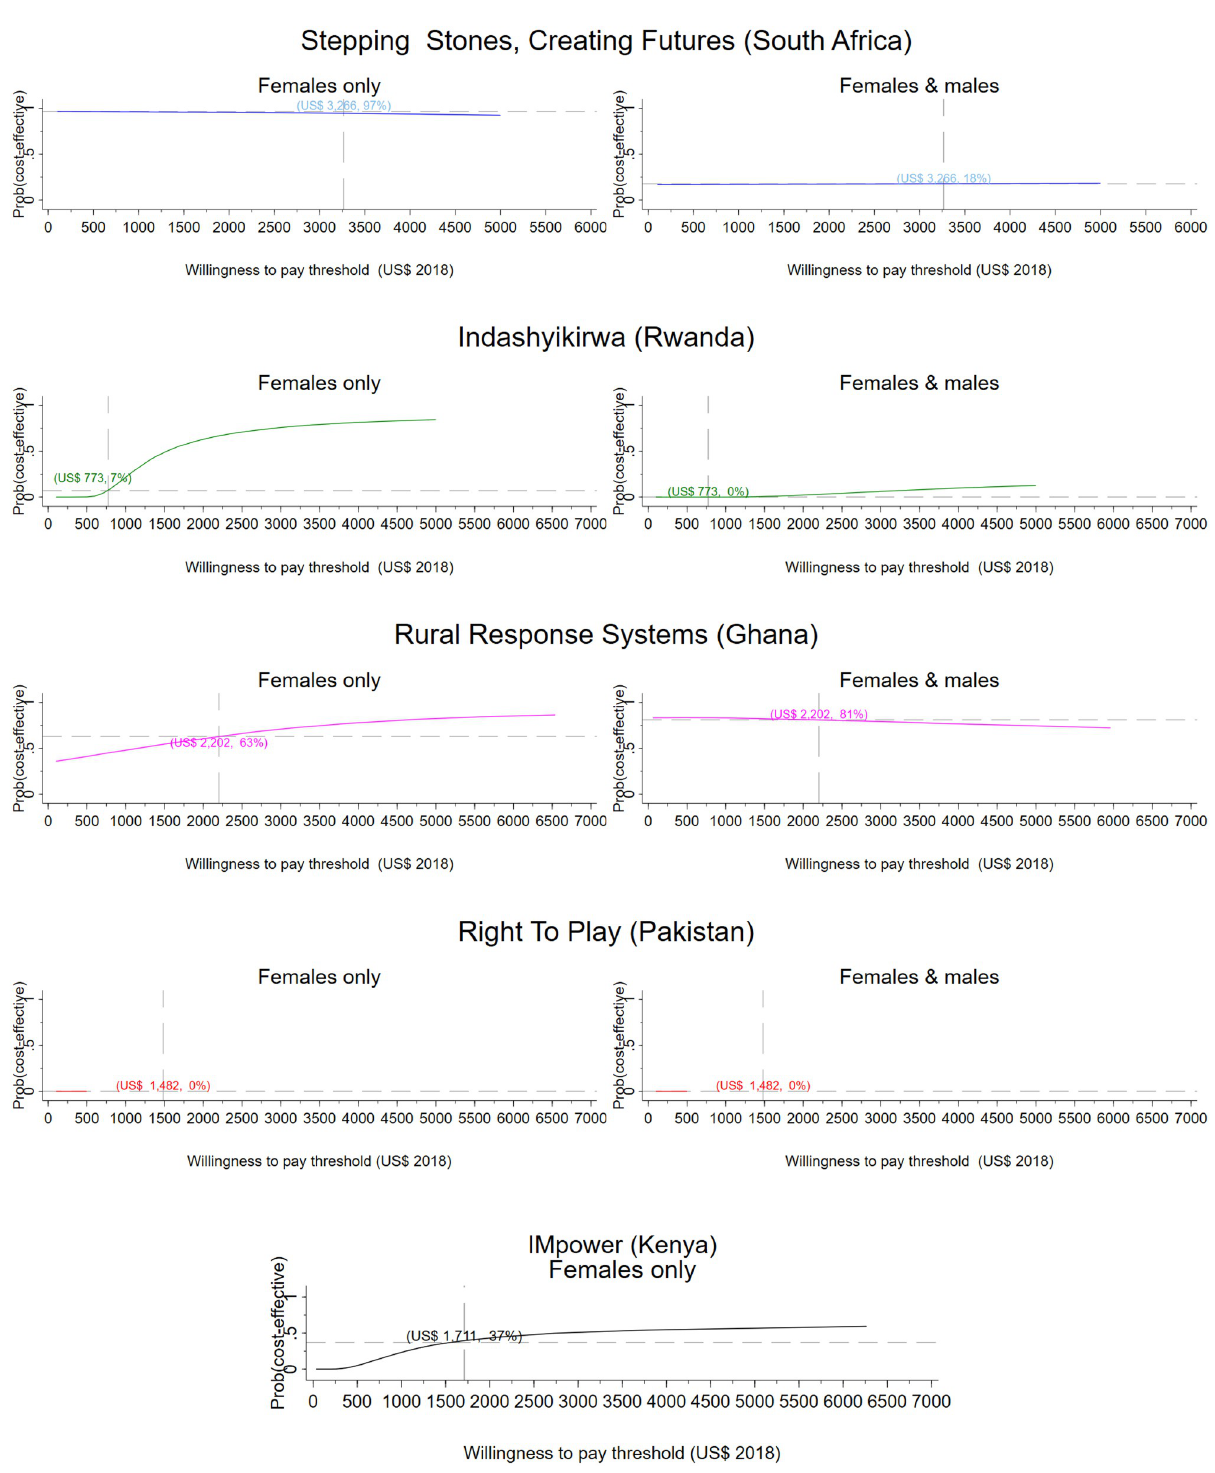
Fig 4. Scale-up scenario 1, societal perspective. CEACs illustrating the probability that the intervention is effective for a range of thresholds. Dashed vertical line: country-specific opportunity cost threshold; dashed horizontal line: probability that the intervention is cost-effective at the country-specific threshold, given the cost per DALY averted by the intervention. CEAC, cost-effectiveness acceptability curve; DALY, disability-adjusted life year.